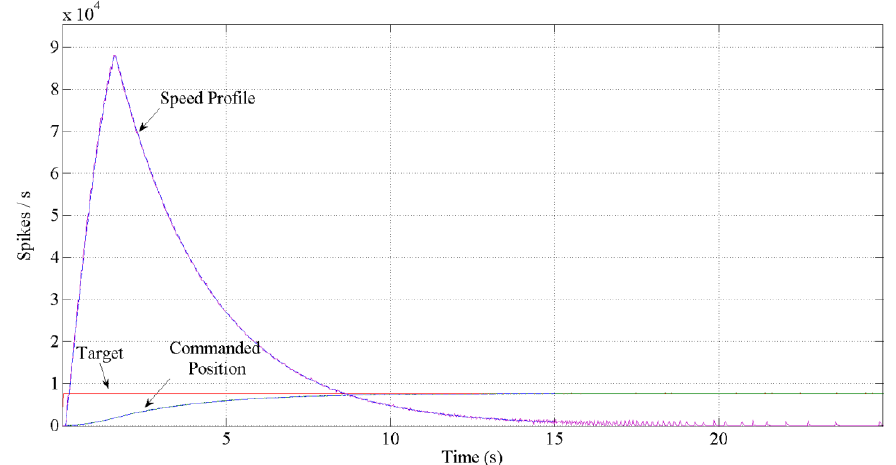
Figure 13. Performance achieved corresponding to ten percentage slope in GO signal. Dotted lines are simulated in front of measurement solid lines. The bell shape profile signals represent the speed. The ripple in the spike-base behavior is due to the function that transforms the spikes into a continuous signal. The target is the same for both simulated and measurements signals and it is represented as a firing rate. It takes a total of 12 s to reach the target if we look through the position.